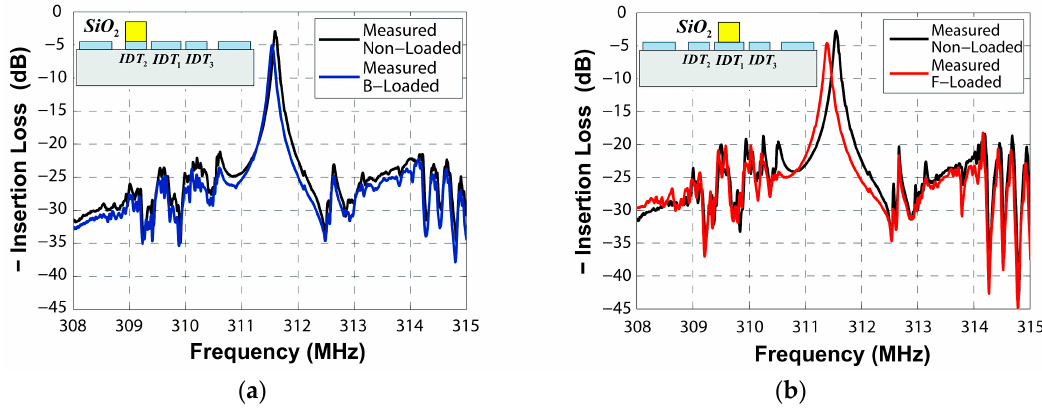
Figure 16. Measured frequency responses caused by ( a ) area B loaded and ( b ) area F loaded by SiO 2 .